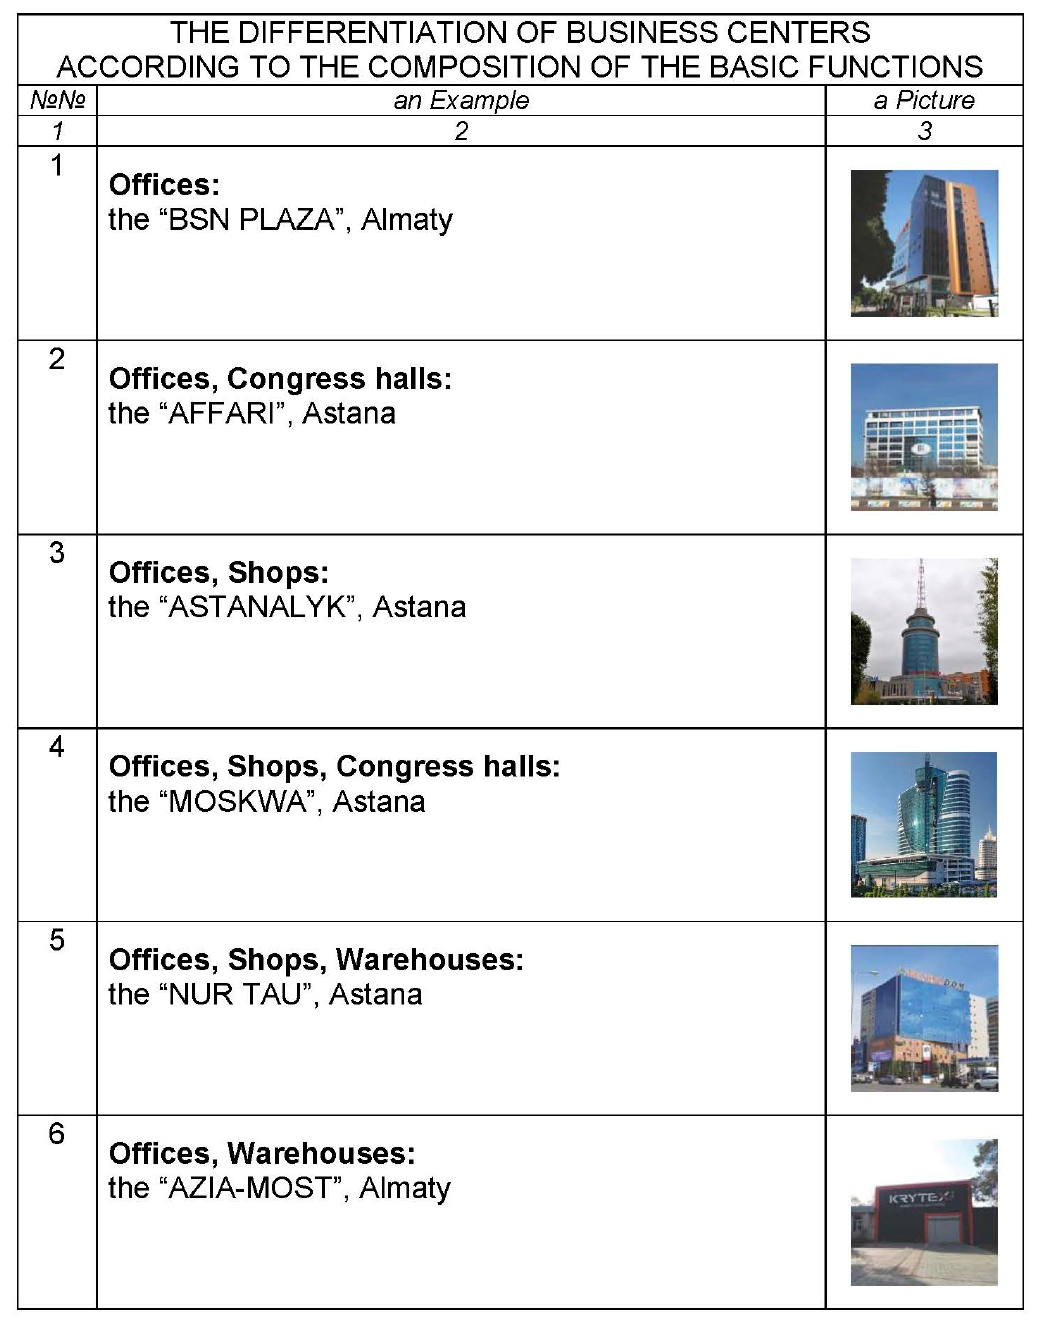
Figure 9. The differentiation of business centers by the composition of basic functions: ( 1 ) the BSN PLAZA, Almaty [104]; ( 2 ) the AFFARI, Astana [105]; ( 3 ) the ASTANALYK, Astana [106]; ( 4 ) the MOSKVA, Astana [107]; ( 5 ) the NUR TAU, Astana [108]; and ( 6 ) the ASIA-MOST, Almaty [109].